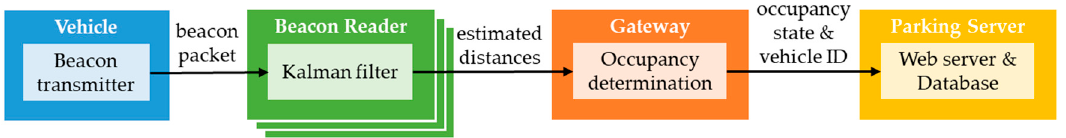
Figure 3. The relationships between the four roles.